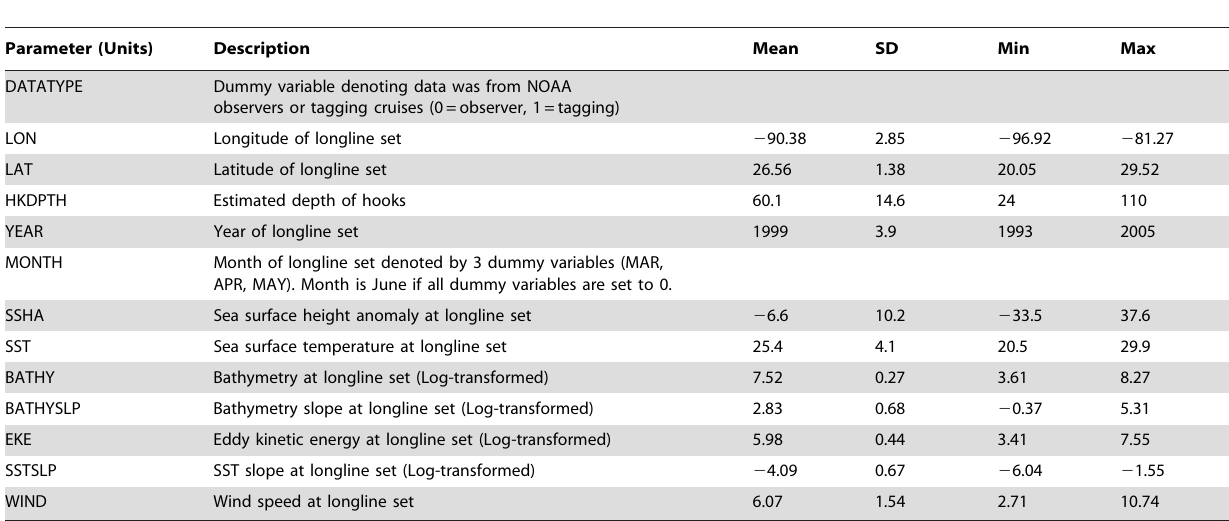
Table 1. Description, mean, standard deviation (SD), and range of environmental parameters used in this study.